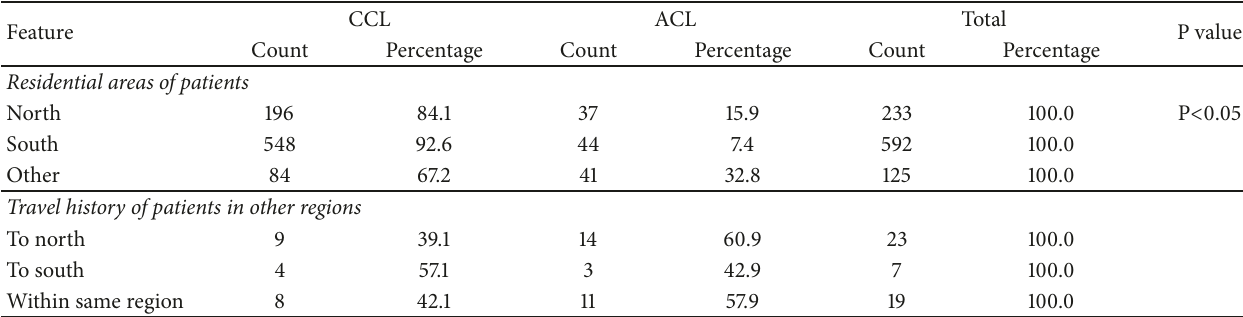
Table 4: Distribution of CCL and ACL in patients from different regions within the